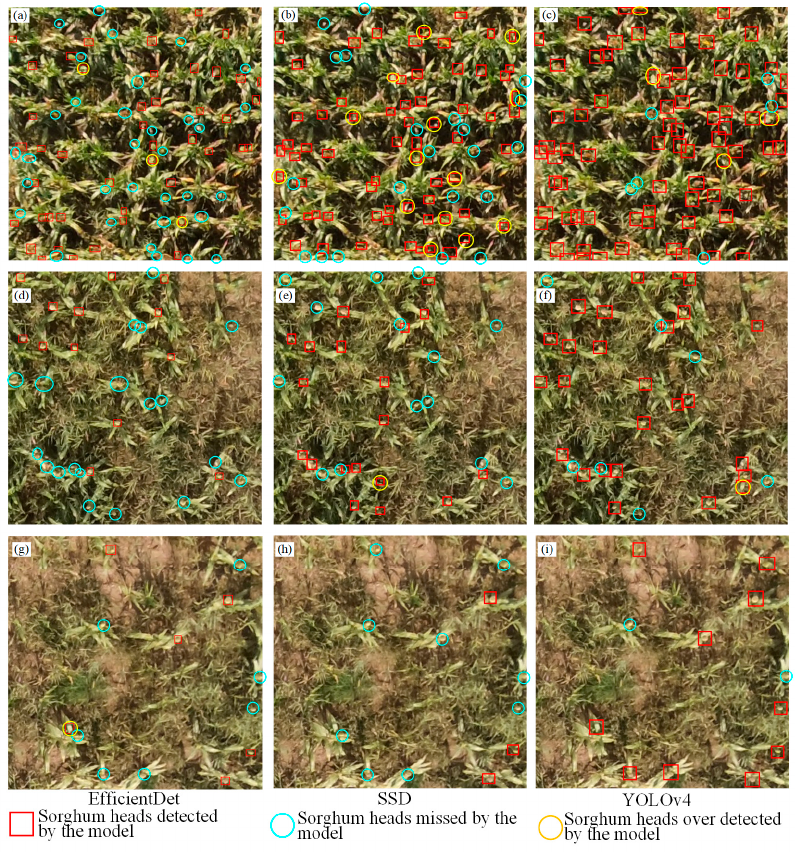
Figure 6. Detection results for sorghum heads with different densities by different algorithms (( a,d,g ), ( b,e,h ) and ( c,f,i ) represents the three DL algorithms of EfficientDet, SSD, and YOLOV4 at the dense, moderate, and sparse conditions, respectively).